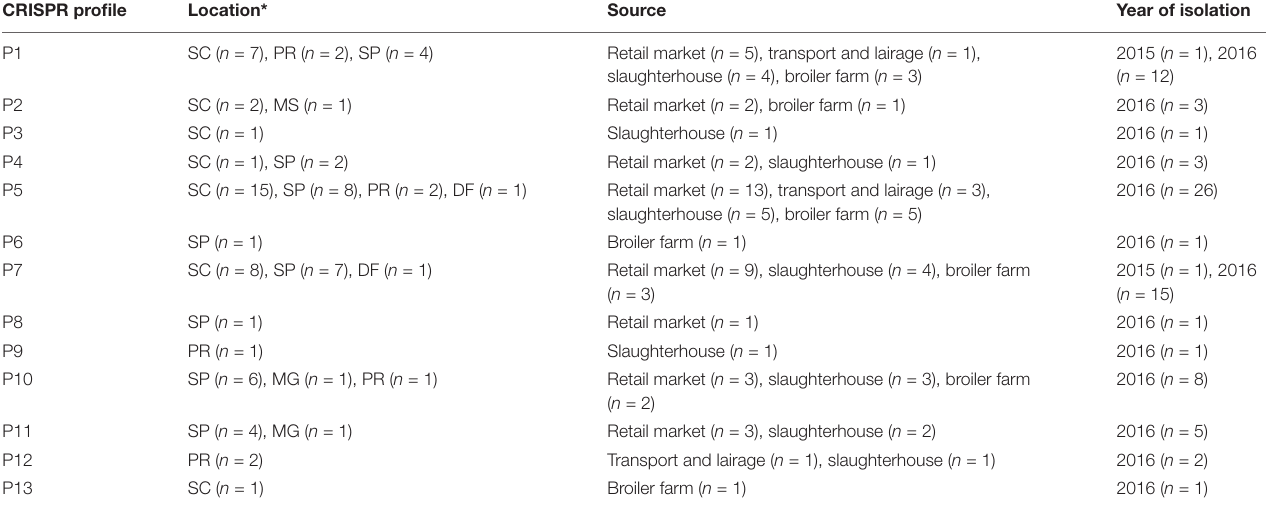
TABLE 3 | Clustered regularly interspaced short palindromic repeats (CRISPR) patterns obtained from 81 Salmonella Heidelberg strains. CRISPR